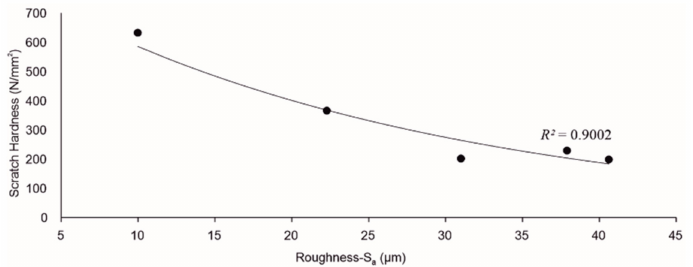
Figure 9. Roughness S a versus scratch hardness of coating surfaces after the scratch test.